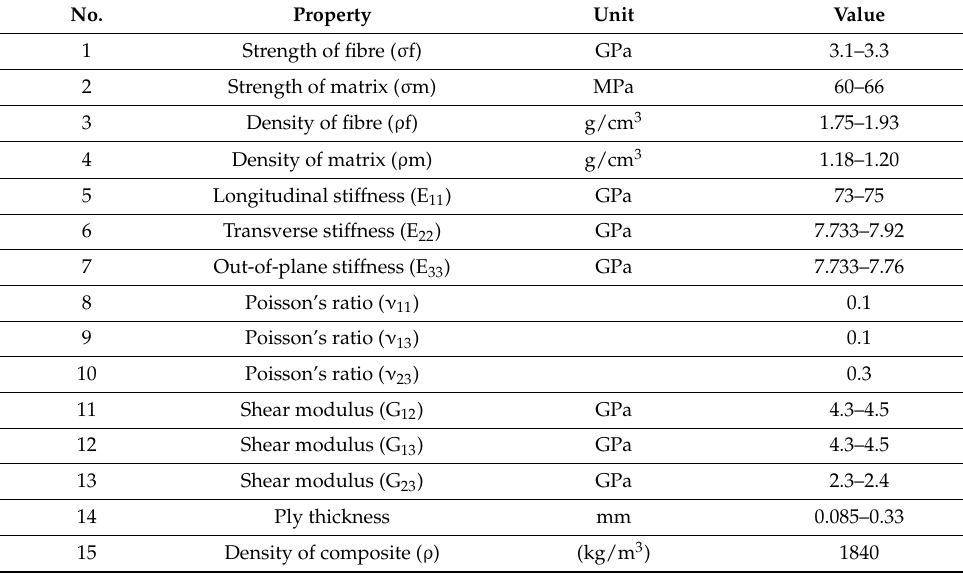
Table 1. Description of the properties of the CF–epoxy laminate that was